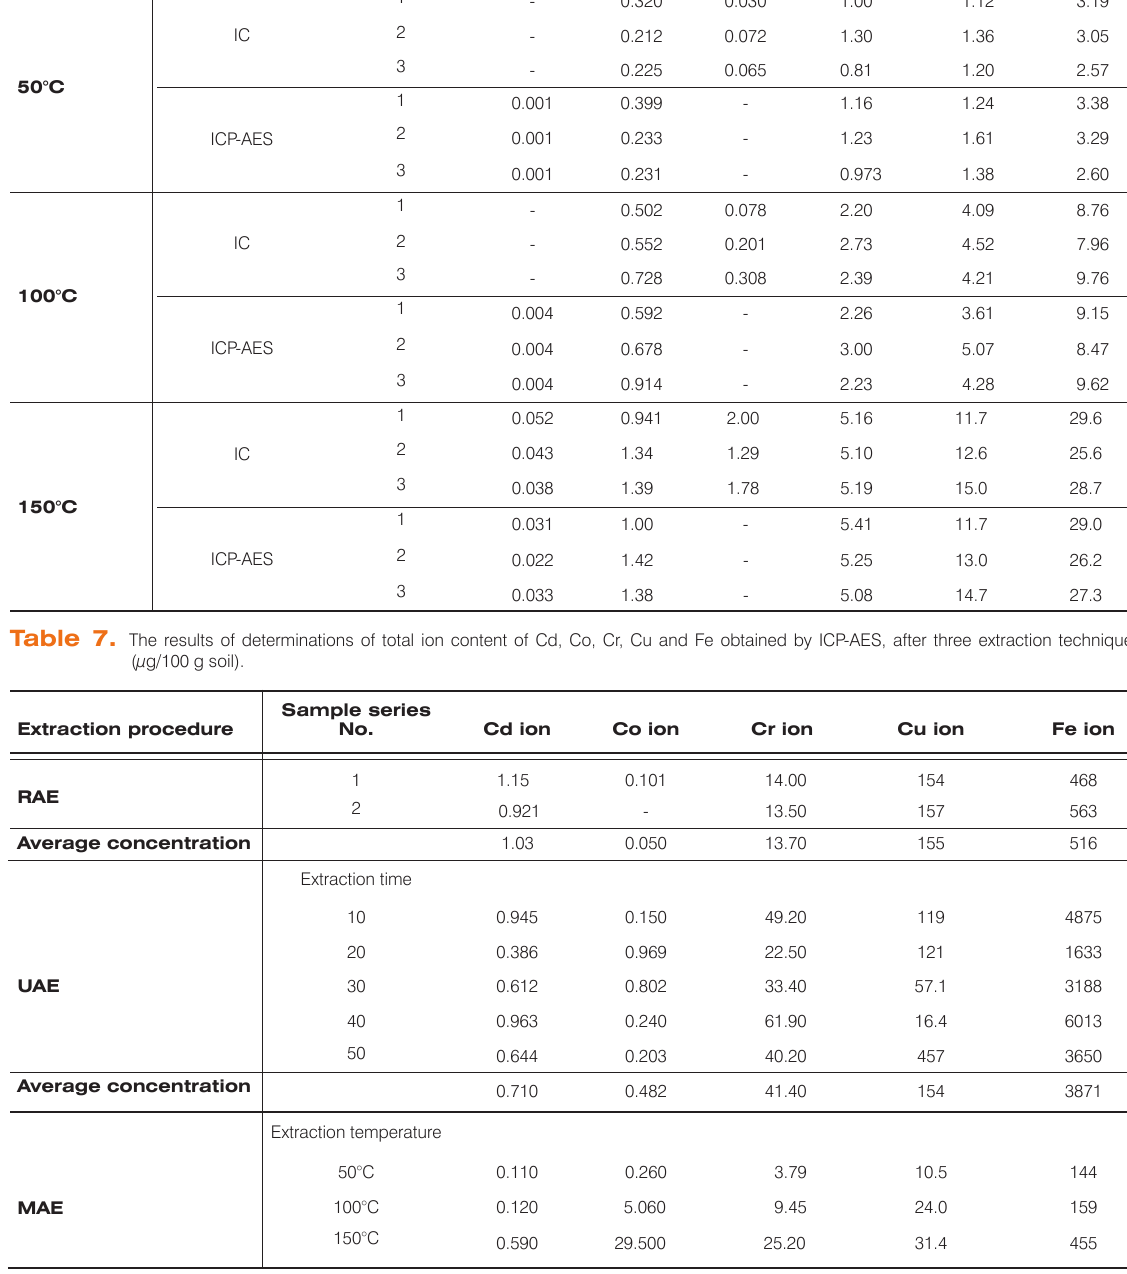
Table 6. The results of determinations of Li + , Na + , NH 4+ , K + , Ca 2+ and Mg 2+ ions obtained by IC and ICP-AES, after MAE (mg/100 g soil). Extraction Determination temperature method